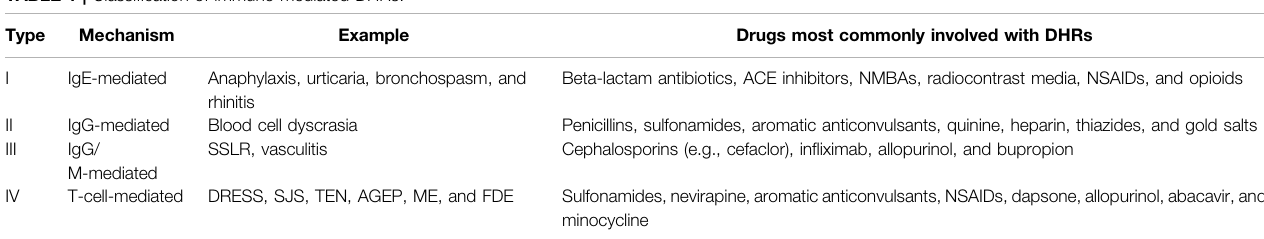
TABLE 1 | Classi fi cation of immune-mediated